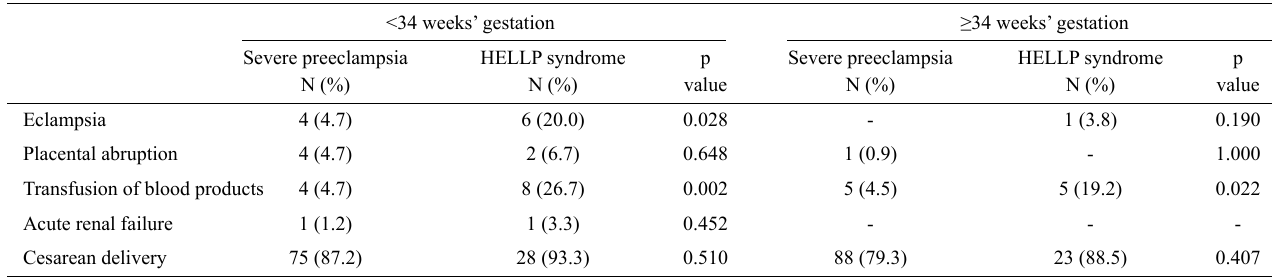
TABLE 2. Maternal